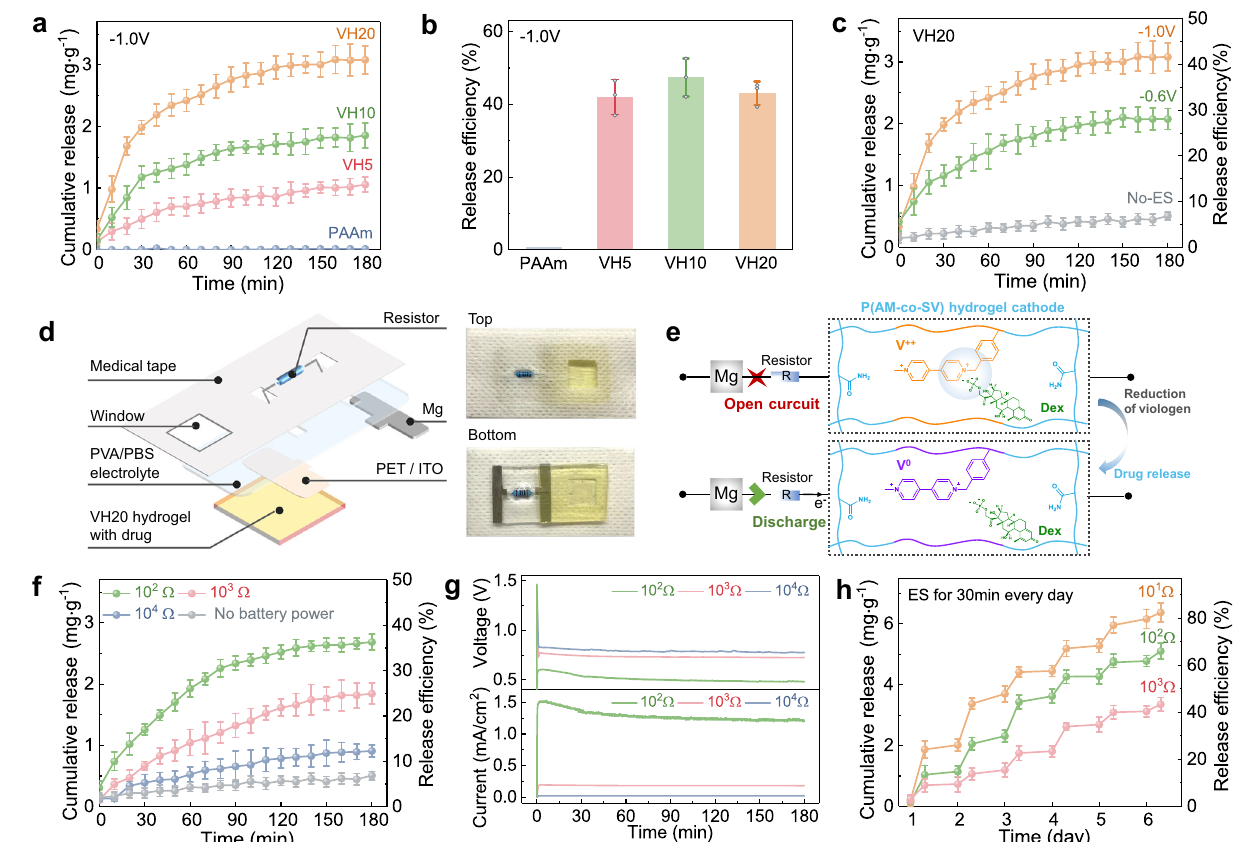
Fig. 4 | On-demand drug release in PBS driven by an external source and ion- tophoresis. a Cumulative amount, and ( b )release ef fi ciency of Dexfrom P(AM-co- SV) hydrogels at a controlled potential of − 1.0V for 180min ( n = 3